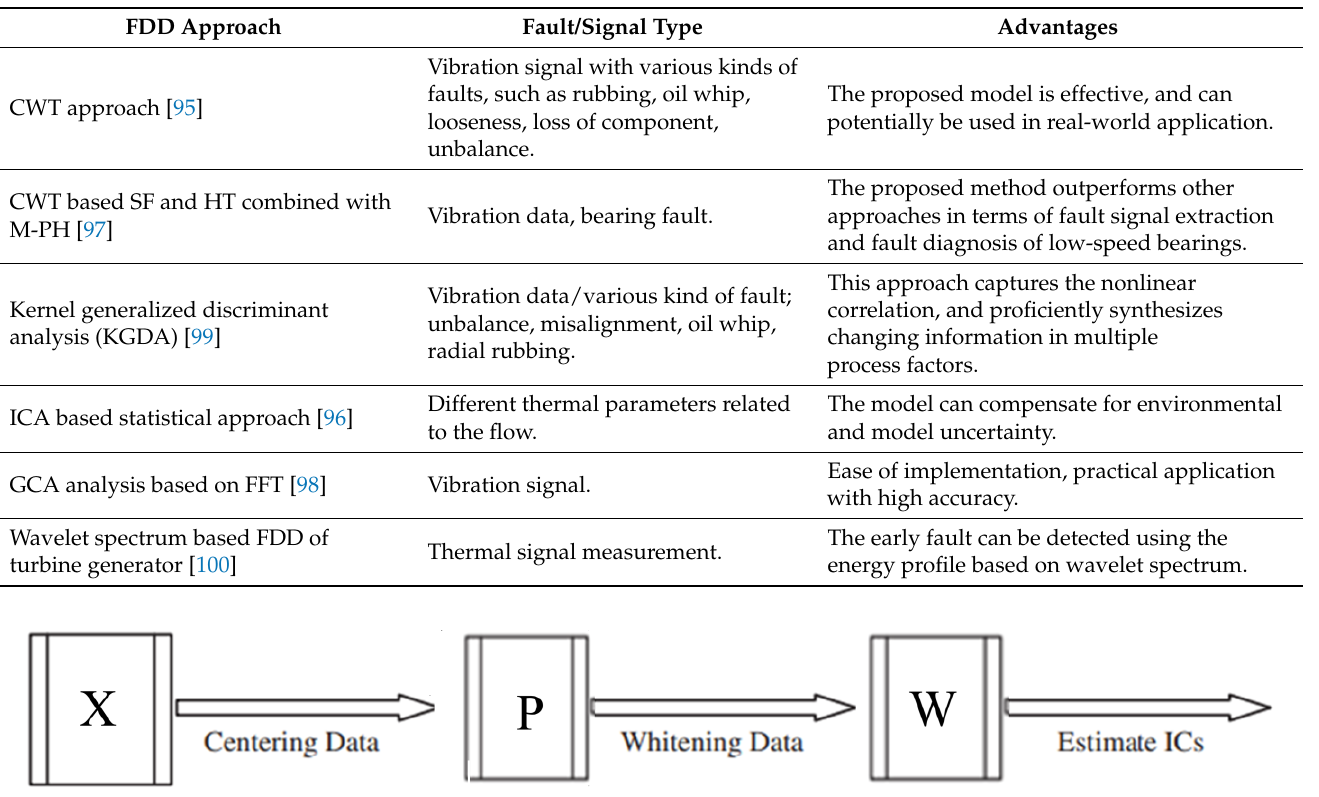
Table 3. Comparison of Statistical-based Fault Detection Techniques for steam turbine Power Plant Systems.